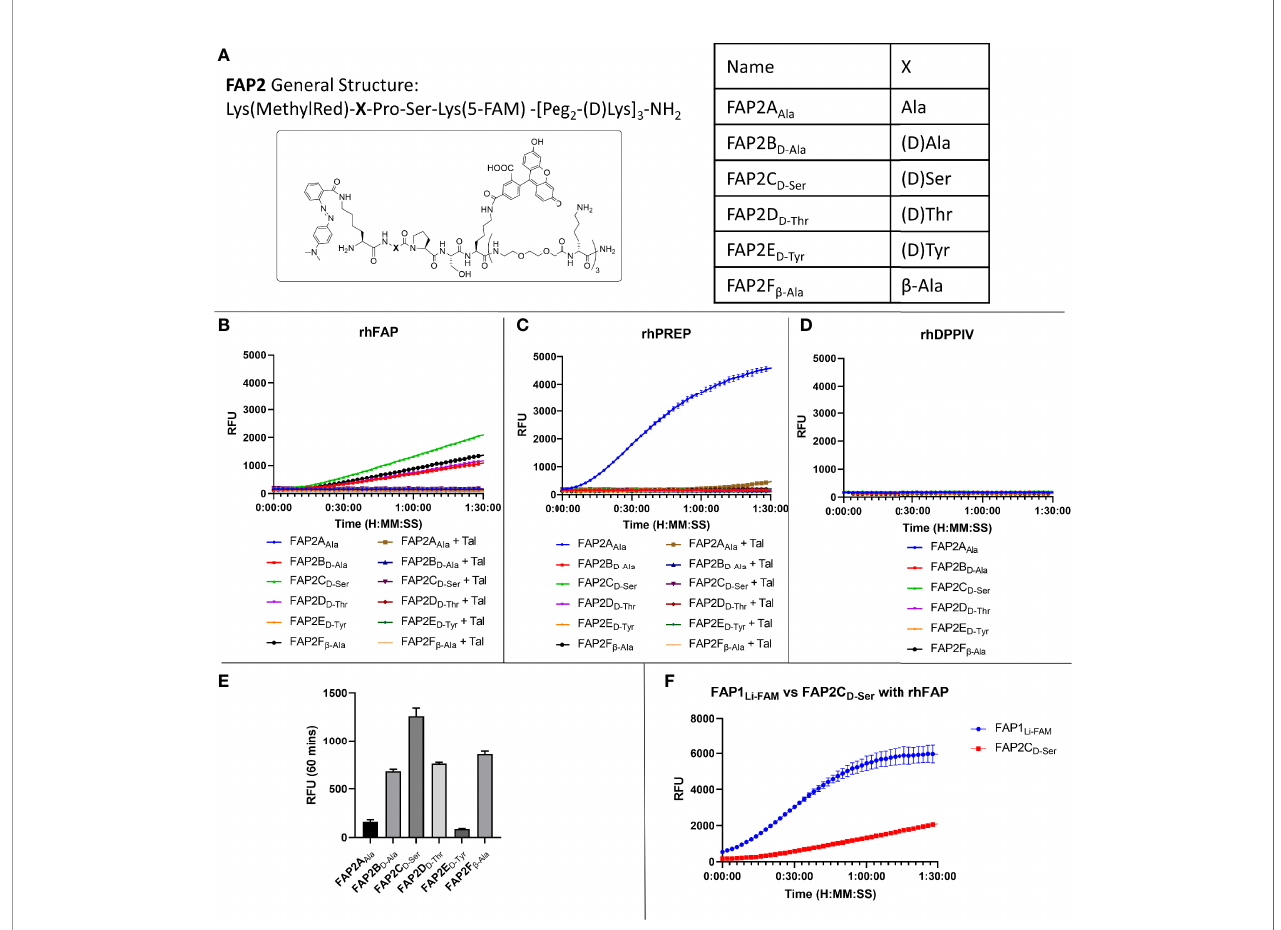
FIGURE 2 | Iterations of probe FAP2 to determine a sequence speci fi c for FAP over PREP. (A) The structure of FAP2 probes and the different variations in the amino acid X; (B) Assessment of the probes (5µM) against rhFAP showing relative intensity and Talabostat (Tal) inhibiting cleavage. FAP2C D-Ser shows highest rate of cleavage; (C) Assessment of the probes (5µM) against rhPREP showing iteration FAP2A Ala is cleaved by rhPREP; (D) Assessment of the probes against DPP-IV (5µM) showing none of the iterations are cleaved; (E) Comparison of the relative fl uorescence intensity of each probe iteration at 60 minutes; (F) Comparison of FAP1 Li-FAM with FAP2C D-Ser showing the signal intensity of FAP1 is higher within 90 minutes. Representative images, n=3, mean RFU plotted in bar graph and error bars show standard